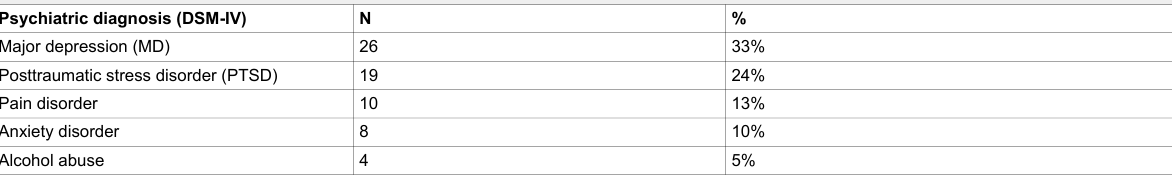
Region of origin